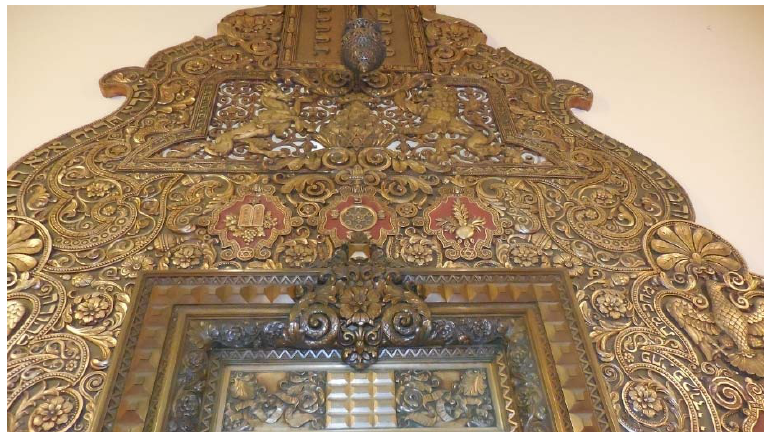
Figure 10. Central section over the ark, including part of the 39 “jewels”.